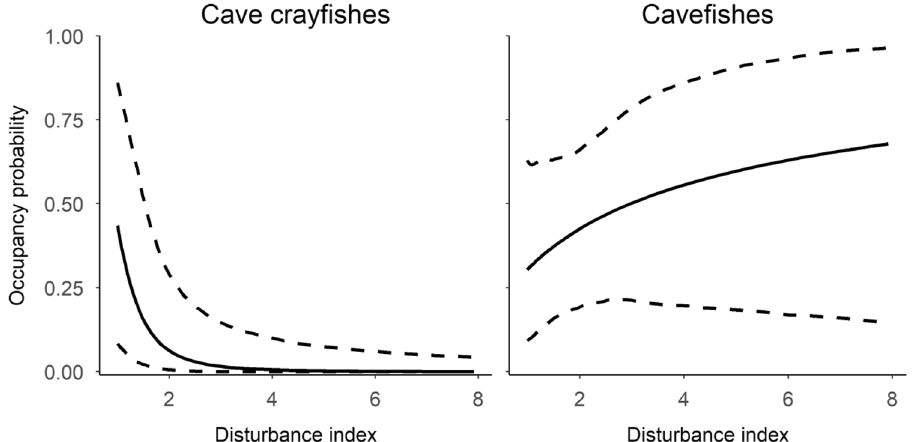
Figure 2. The modeled relationship between human disturbance and occurrence probability of cavefishes and cave crayfishes. Lower numbers along the x-axis indicate less human disturbance, whereas higher numbers indicate higher human disturbance. Solid lines depict the modeled relationship and dotted lines reflect 95% confidence limits (i.e., the uncertainty around the estimated occurrence probability). The categorical variable lithology was set to